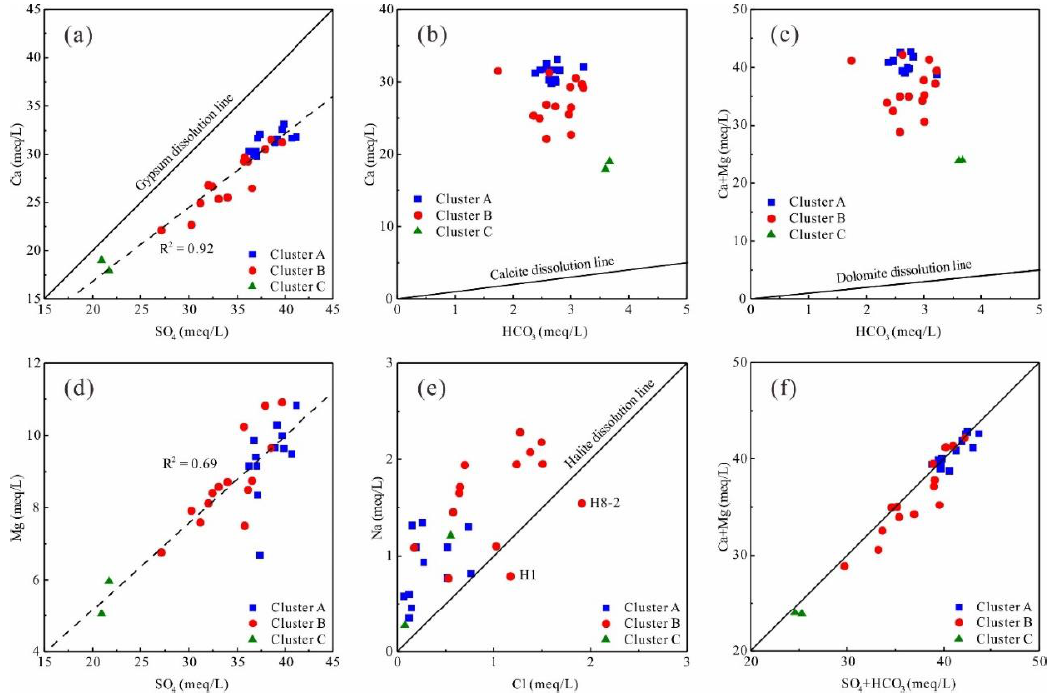
Figure 10. Plots of ions ratios in the hot water samples: ( a) SO 42− vs. Ca 2+ ; ( b) HCO 3− vs. Ca 2+ ; ( c) HCO 3− vs. (Ca 2+ + Mg 2+ ); ( d) SO 42− vs. Mg 2+ , ( e) Cl − vs. Na + ; ( f) (SO 42− + HCO 3− ) vs. (Ca 2+ + Mg 2+ ).